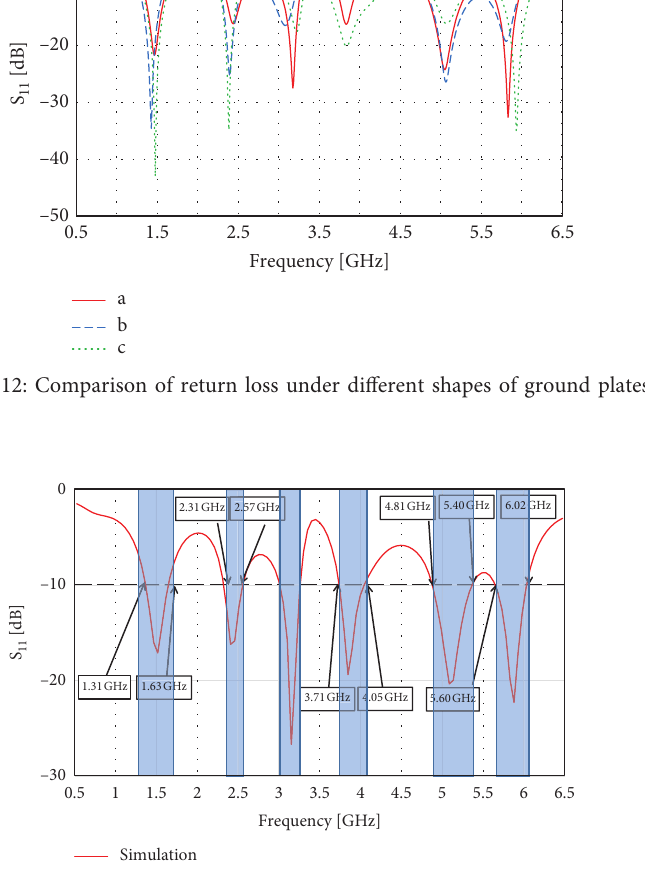
Figure 13: The return loss of a multiband microstrip antenna with a cross-structure imitation classical